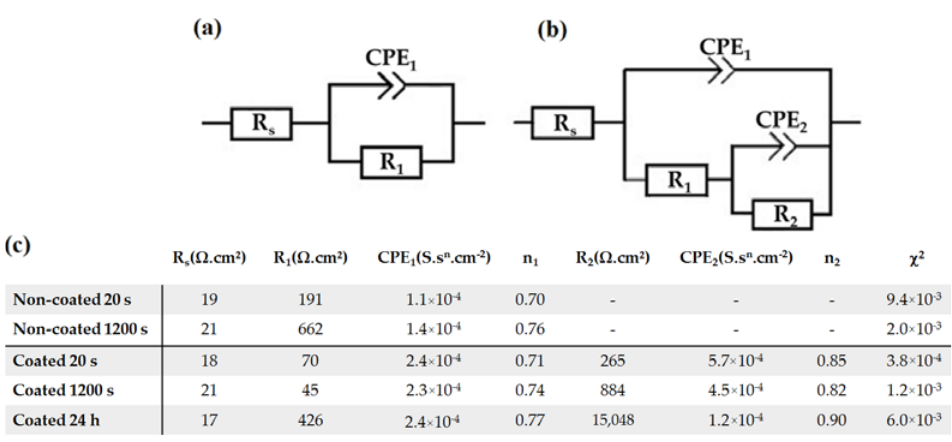
Figure 11. Electrical equivalent circuits used in this study. Representation of equivalent circuit for non-coated ( a ) and coated ( b ) samples, respectively, and the fitted electrical parameters ( c ).